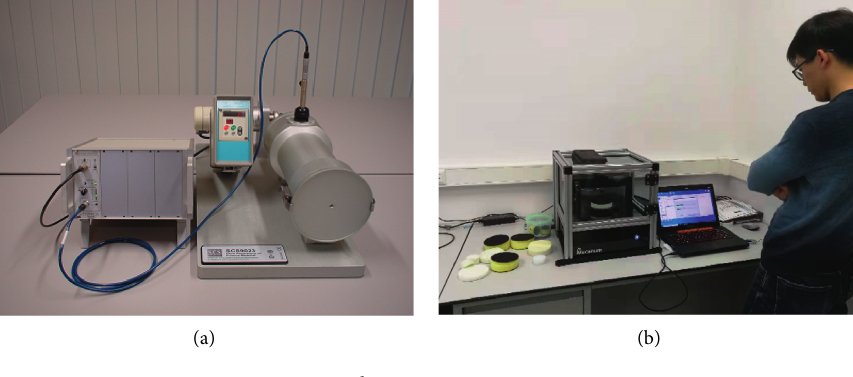
Figure 6: Flow resistance test picture.